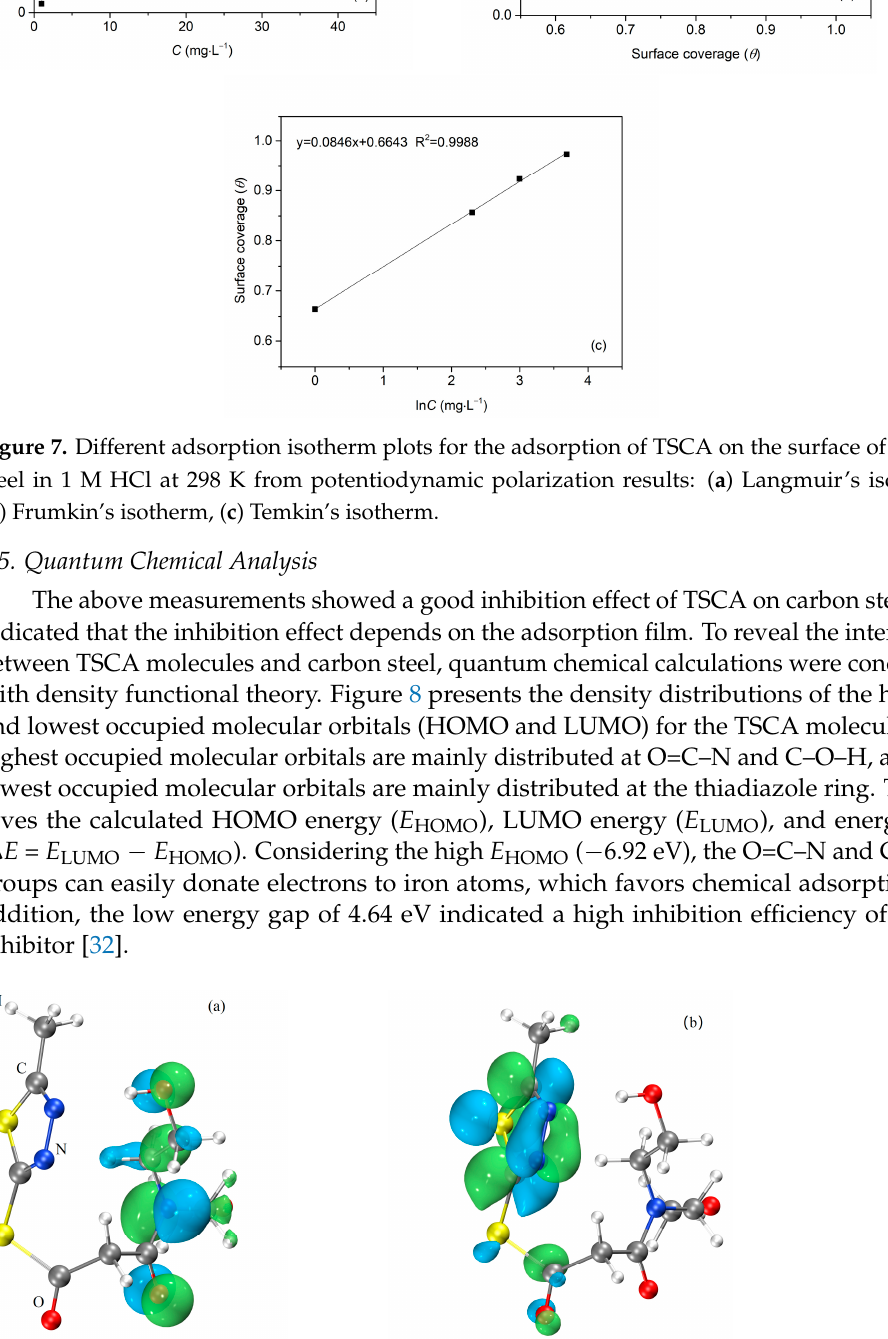
Figure 6. Different adsorption isotherm plots for the adsorption of TSCA on the surface of carbon steel in 1 M HCl at 298 K from EIS results: ( a ) Langmuir’s isotherm, ( b ) Frumkin’s isotherm, ( c ) Temkin’s isotherm.